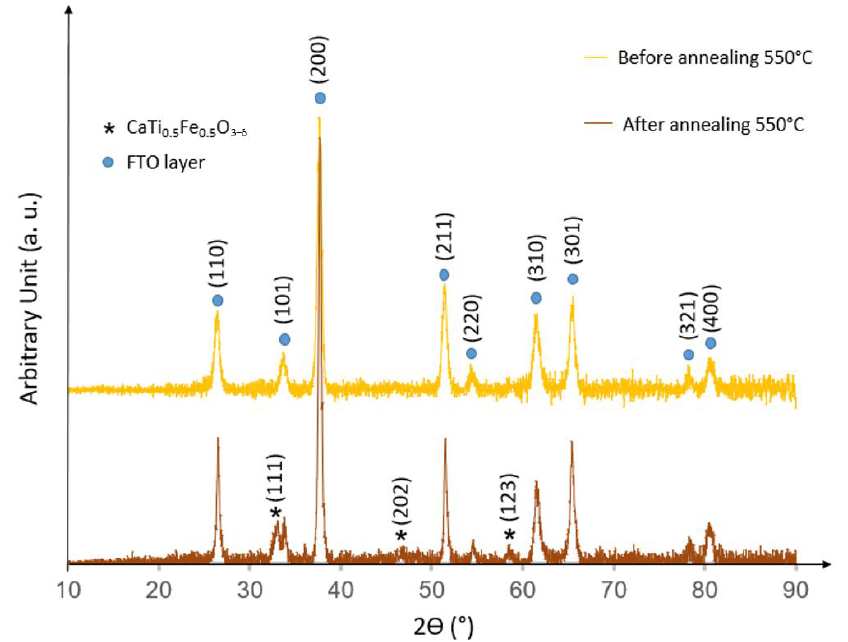
Figure 3. X-ray diffraction patterns of the FTO (200 nm in thickness on top of glass substrate), CTF55 perovskite films before and after annealing at 550 °C under N2 pressure.